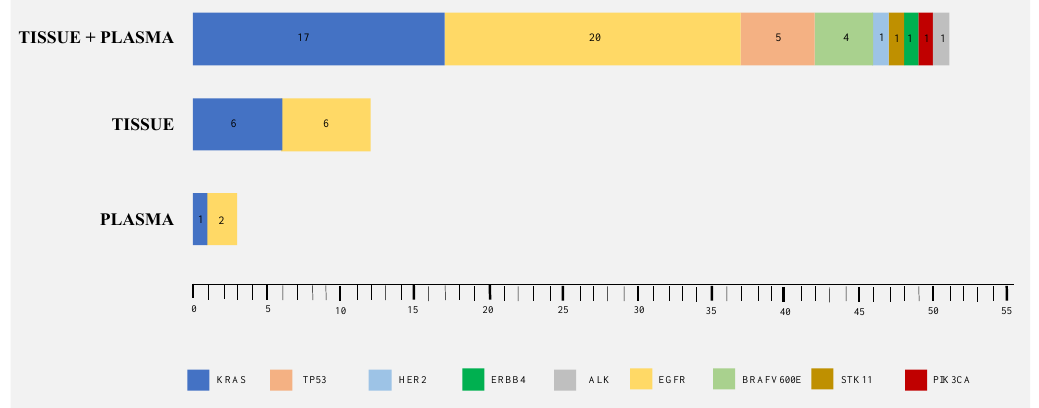
Figure 1. Number of mutations detected in tumor tissue and ctDNA NGS (66 hotspot mutations detected, 51 on both tissue and plasma, 12 exclusively on tissue, and 3 exclusively on plasma).